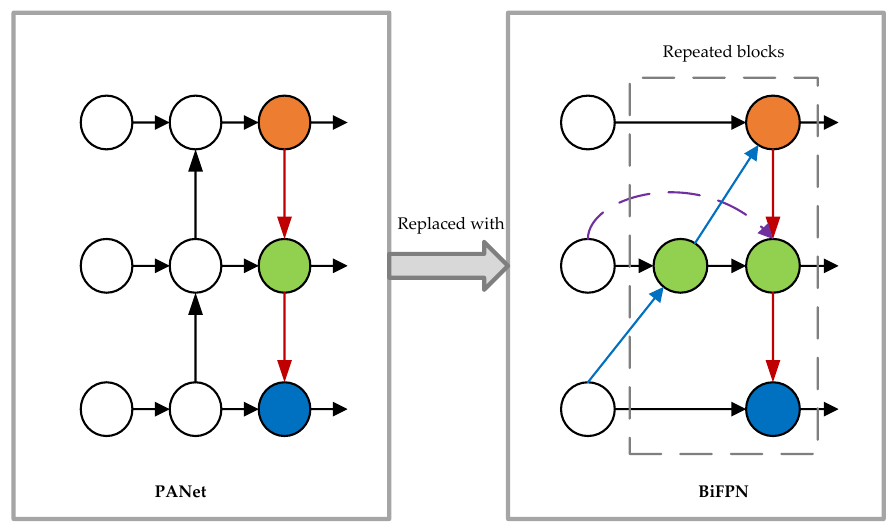
Figure 10. Replacing PANet with BiFPN to improve Feature Fusion Network. For PANet, a top- down and bottom-up pathway were adopted to fuse multi-scale features; for BiFPN, the strategy for top-down and bottom-up bidirectional feature fusion was used and then repeated, applying the same block.